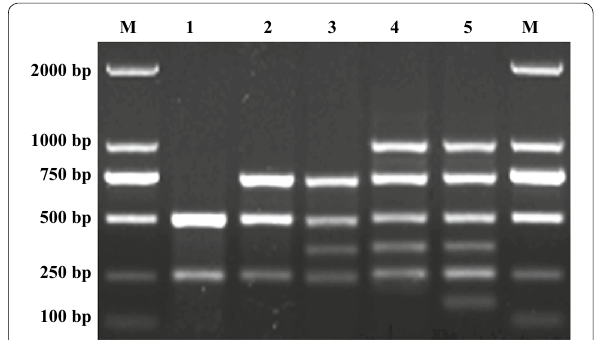
Fig. 2 Optimization of the primers of m-PCR. Lane M: 2000 bp DNA marker; Lane 1: double PCR formed by Proteus mirabilis and Salmonella spp.; Lane 2: triple PCR formed by Proteus mirabi lis, Salmonella spp. and Pasteurella multocida ; Lane 3: quadruple PCR formed by Proteus mirabi lis, Salmonella spp., Pasteurella multocida and Pseudomonas aeruginosa ; Lane 4: quintuple PCR formed by Proteus mirabi lis, Salmonella spp., Pasteurella multocida , Pseudomonas aeruginosa and Escherichia coli ; Lane 5: sextuple PCR formed by Proteus mirabi lis, Salmonella spp., Pasteurella multocida , Pseudomonas aeruginosa , Escherichia coli and Staphylococcus